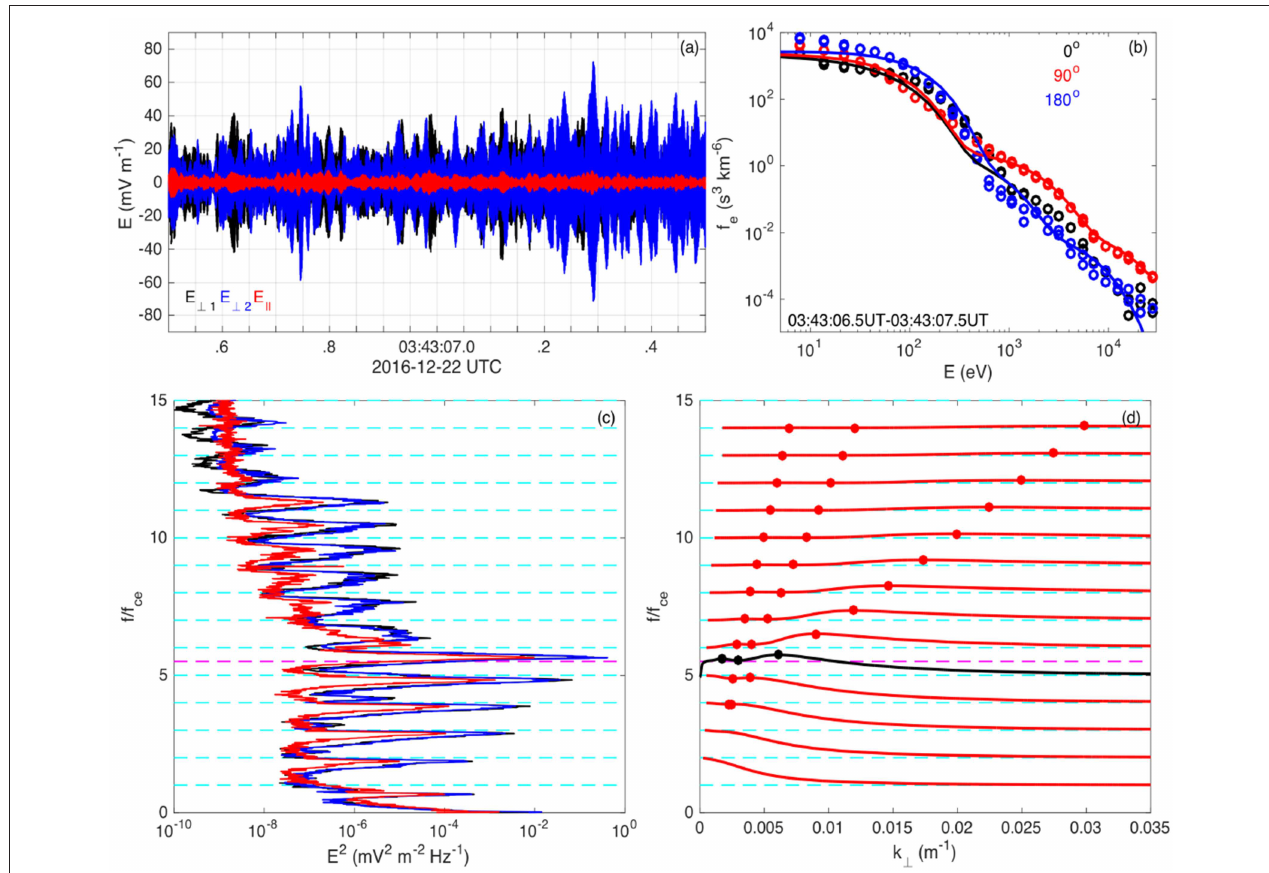
FIGURE 2 | Example of UH and electron Bernstein waves observed by MMS at the reconnecting magnetopause from Graham et al. (2018). (a) Waveform in field-aligned coordinates. (b) Observed electron distribution associated with the waves (circles) and fitted distribution (solid lines). The black, red, and blue colors indicate the phase-space densities at pitch angles 0 ◦ , 90 ◦ , 180 ◦ , respectively. (c) Power spectra of the three electric field components. (d) Predicted dispersion relations of the UH waves (black), and electron Bernstein waves (red). The dots indicate points where the group velocity is zero. In (c,d) the cyan dashed lines indicate nf ce and the magenta dashed line indicates f uh